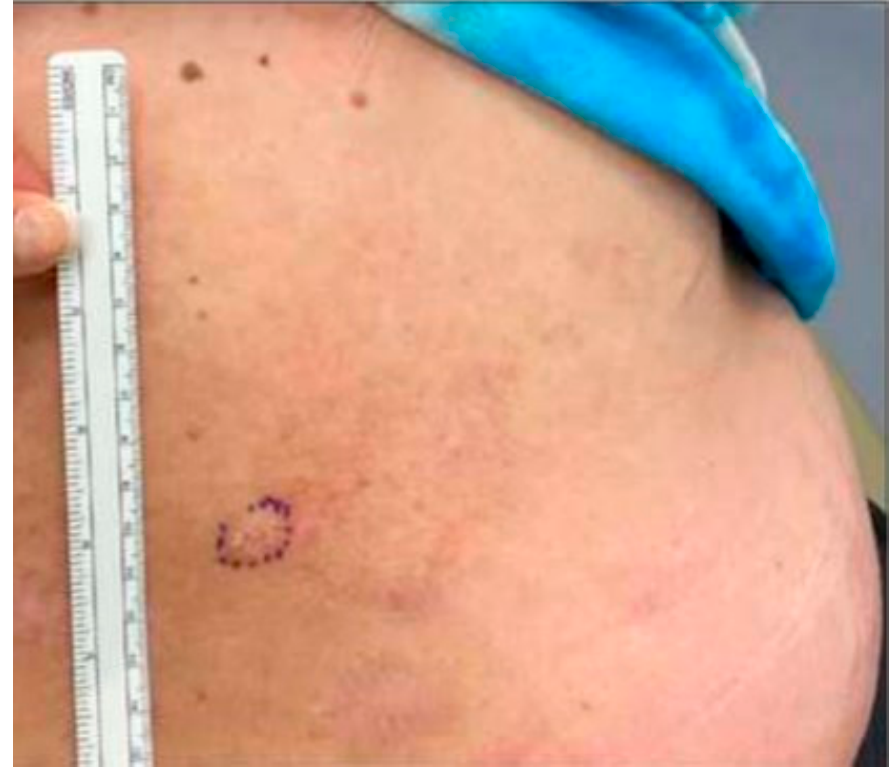
Figure 1. Clinical appearance of 1.8 cm × 1.1 cm hyperkeratotic plaque on the right mid-back.